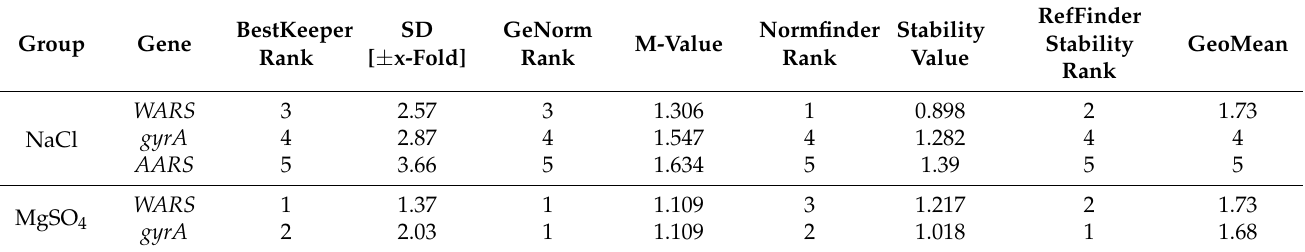
Table 3. Reference genes ranked by their expression stability calculated by BestKeeper, GeNorm, NormFinder and